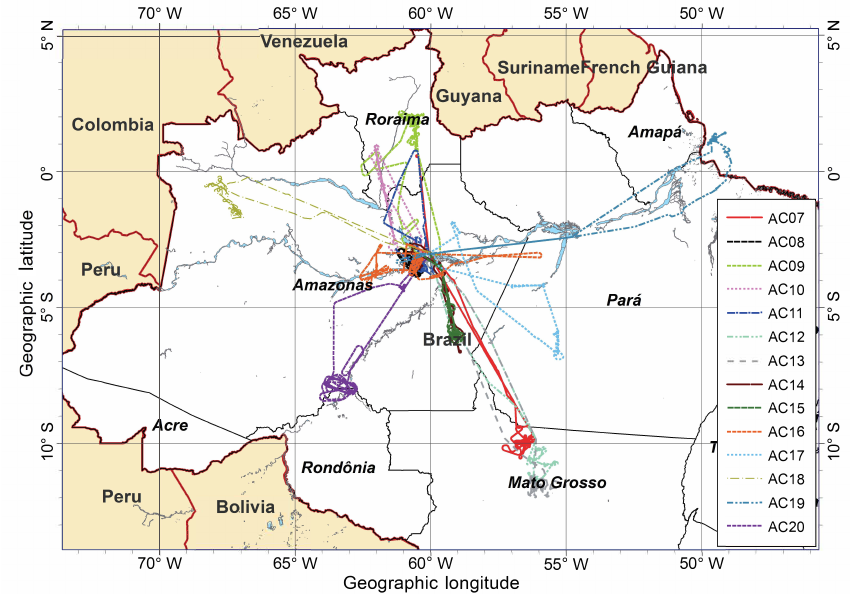
Figure 2. HALO flight tracks during the ACRIDICON–CHUVA experiment. The flight numbers are indicated on the right (from Wendisch et al.,